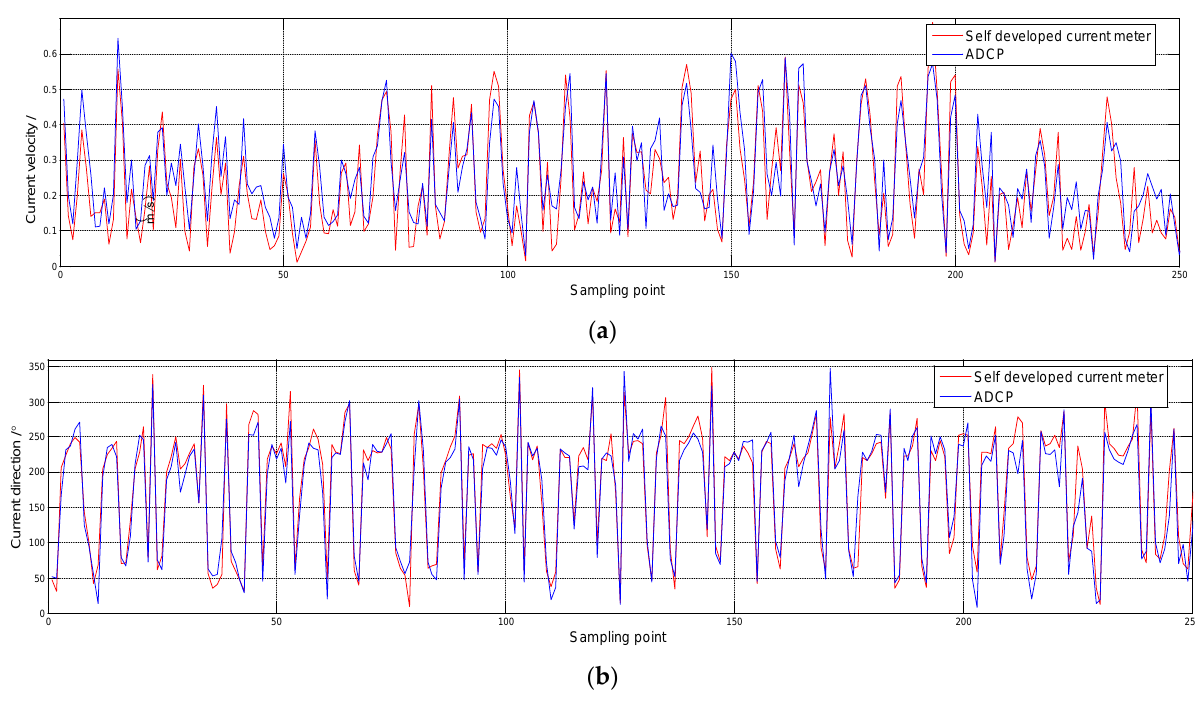
Figure 14. Comparison of the velocity and direction curves between ECM and Nortek ADCP. ( a ) Current velocity. ( b ) Current direction.